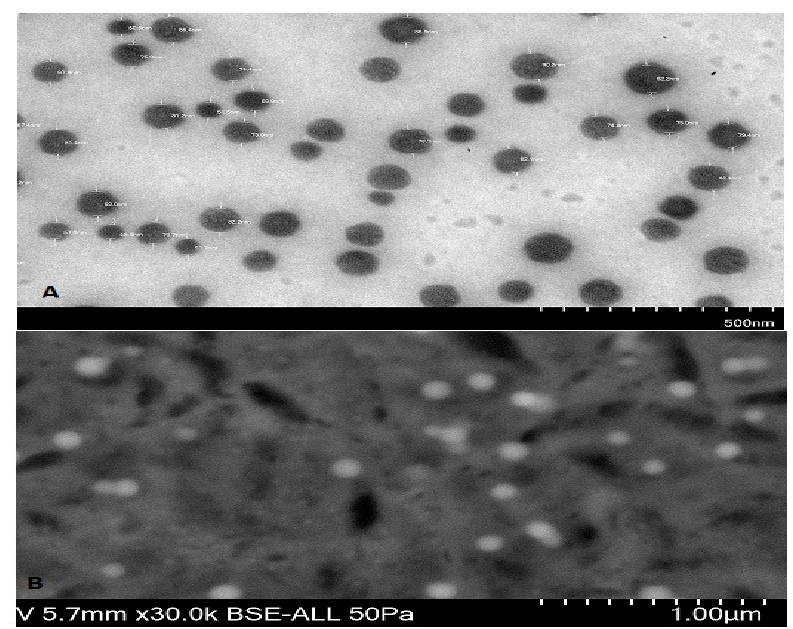
Figure 3. Microphotograph of NAR NPs by ( A ) Transmission Electron Microscope (TEM) and ( B ) Field Emission Scanning Electron Microscope (FESEM).